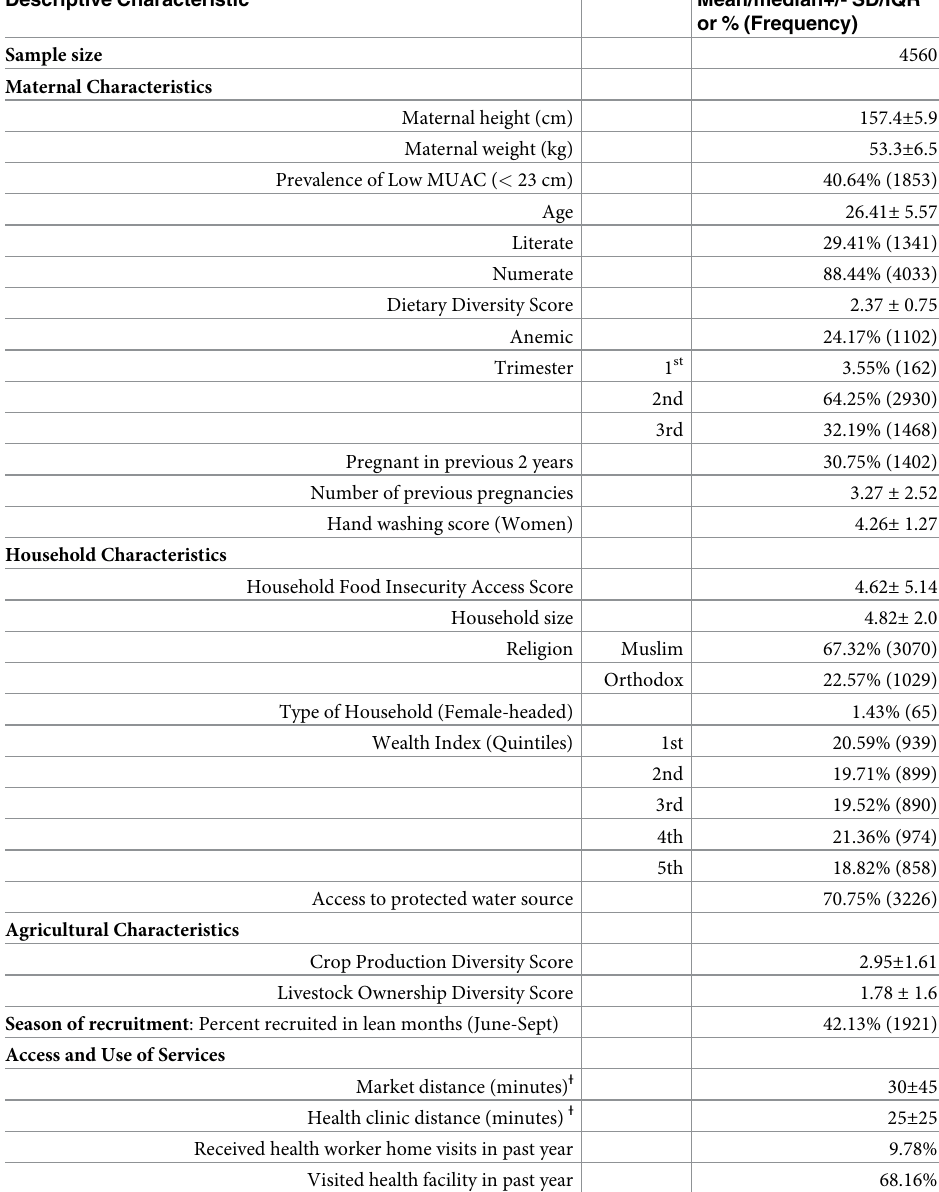
Table 1. Descriptive